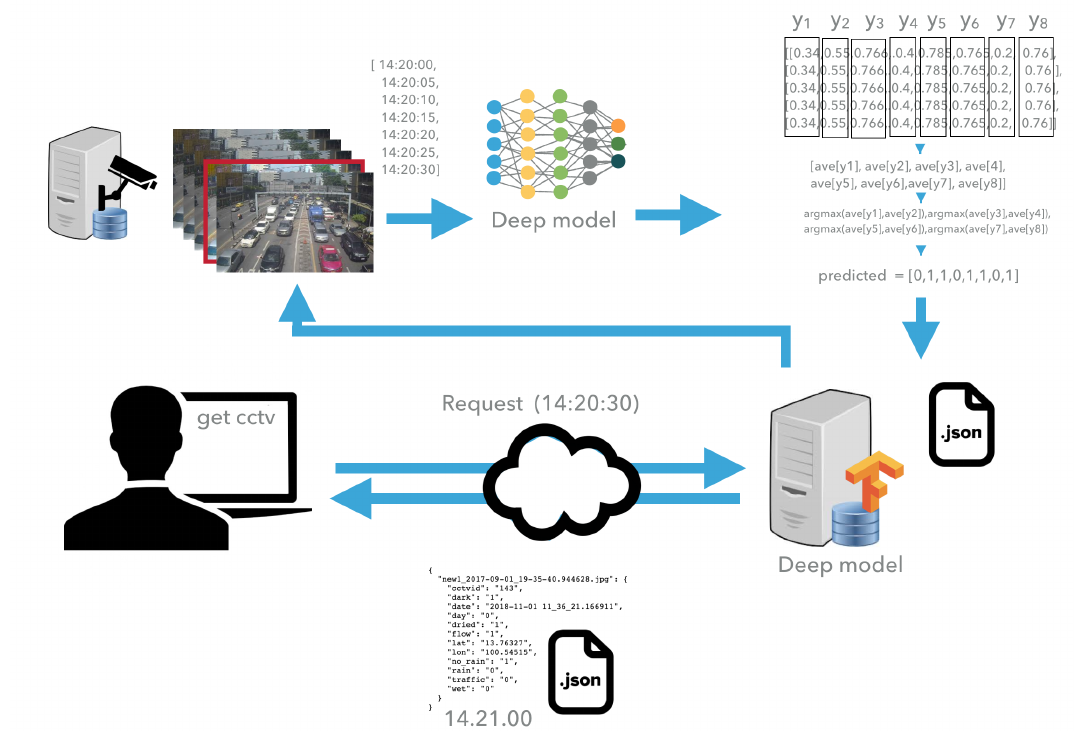
Figure 6. Process of predicting the